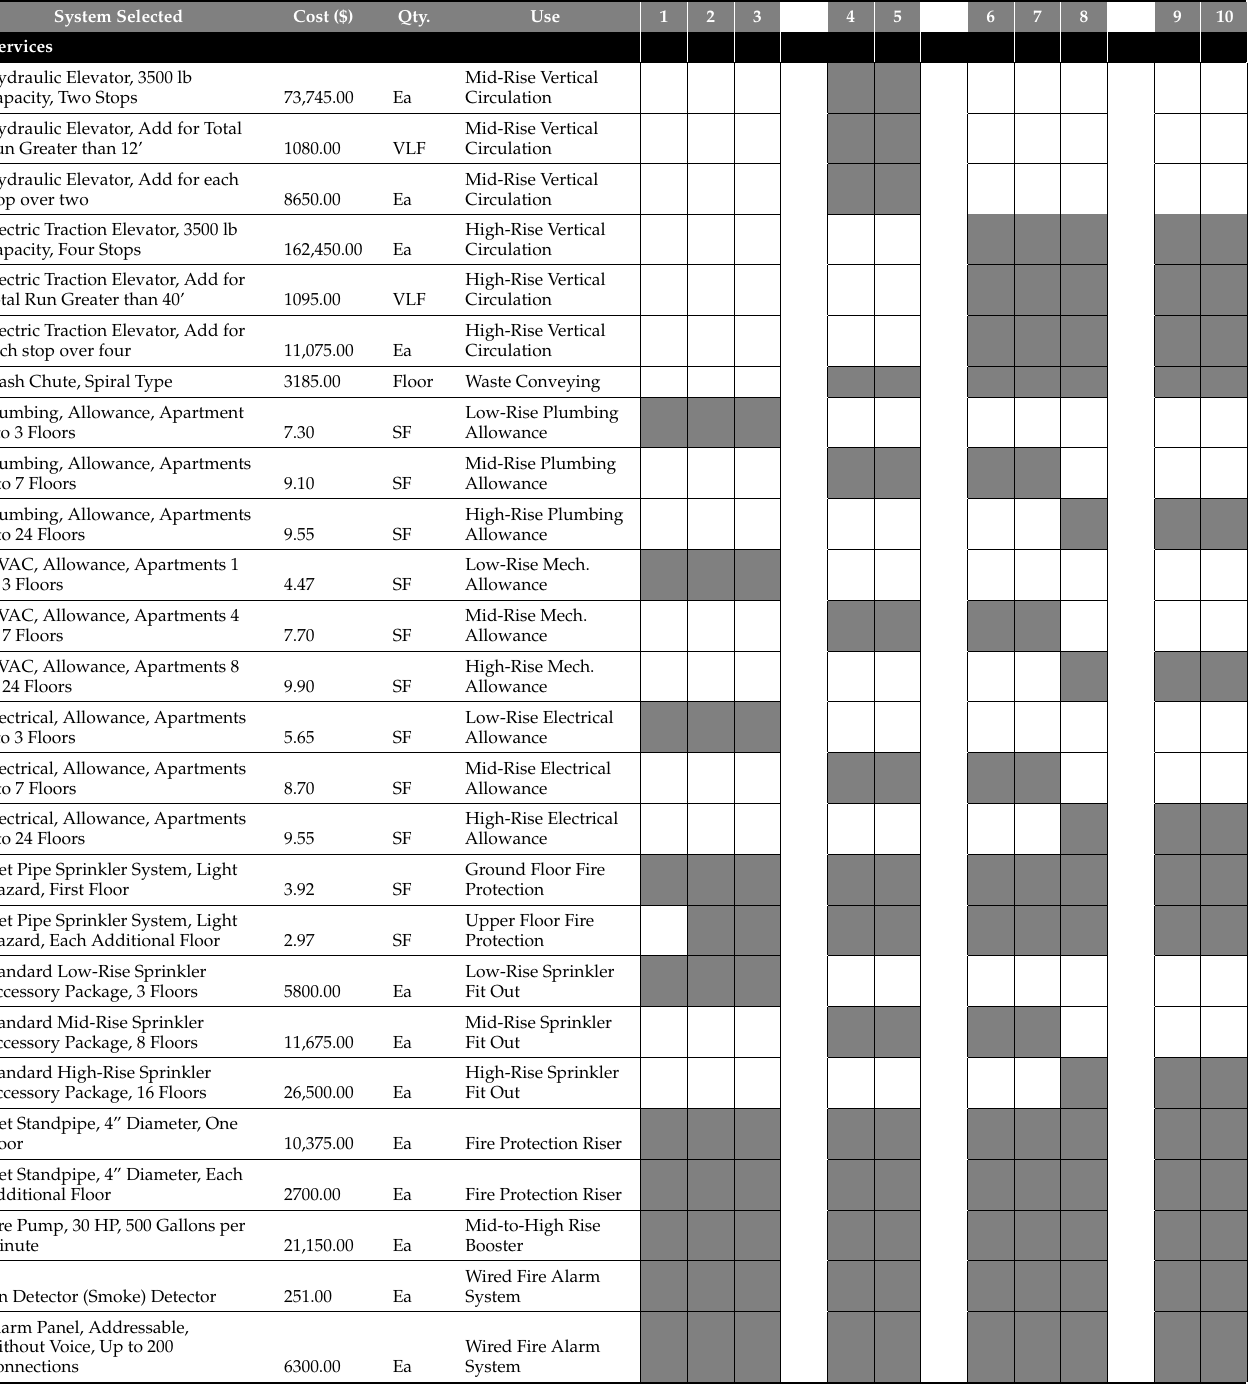
Table 4. Building Services Systems, Costs, and Designated